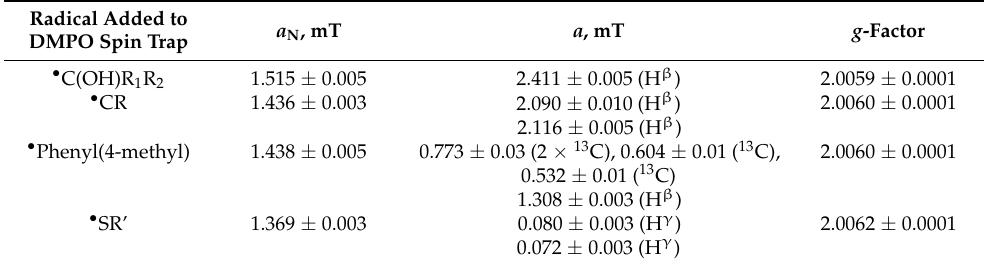
Table 4. Spin-Hamiltonian parameters of DMPO spin-adducts evaluated from the simulation spectra measured in acetonitrile at 295